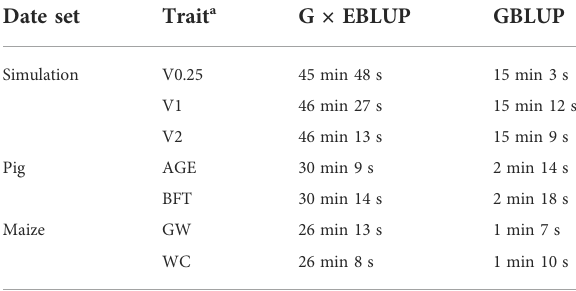
TABLE 4 Average computation time for G × EBLUP and GBLUP to complete each fold of cross-validation. Date